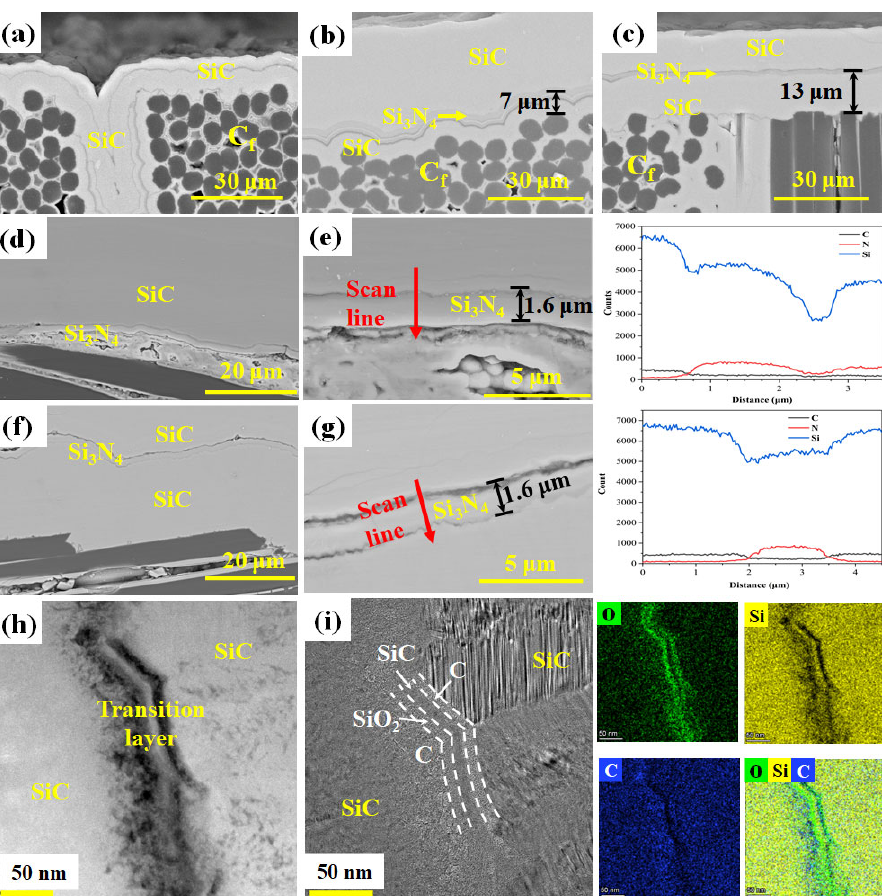
Fig. 3 BSE images of polished cross-sections of (a) sample S0, (b) sample S1, and (c) sample S2. High-magnification BSE images and corresponding EDS images of the marked scan lines of (d, e) sample S1 and (f, g) sample S2, respectively. (h) HADDF-STEM image and (i) HRTEM image and corresponding EDS mapping of CVI